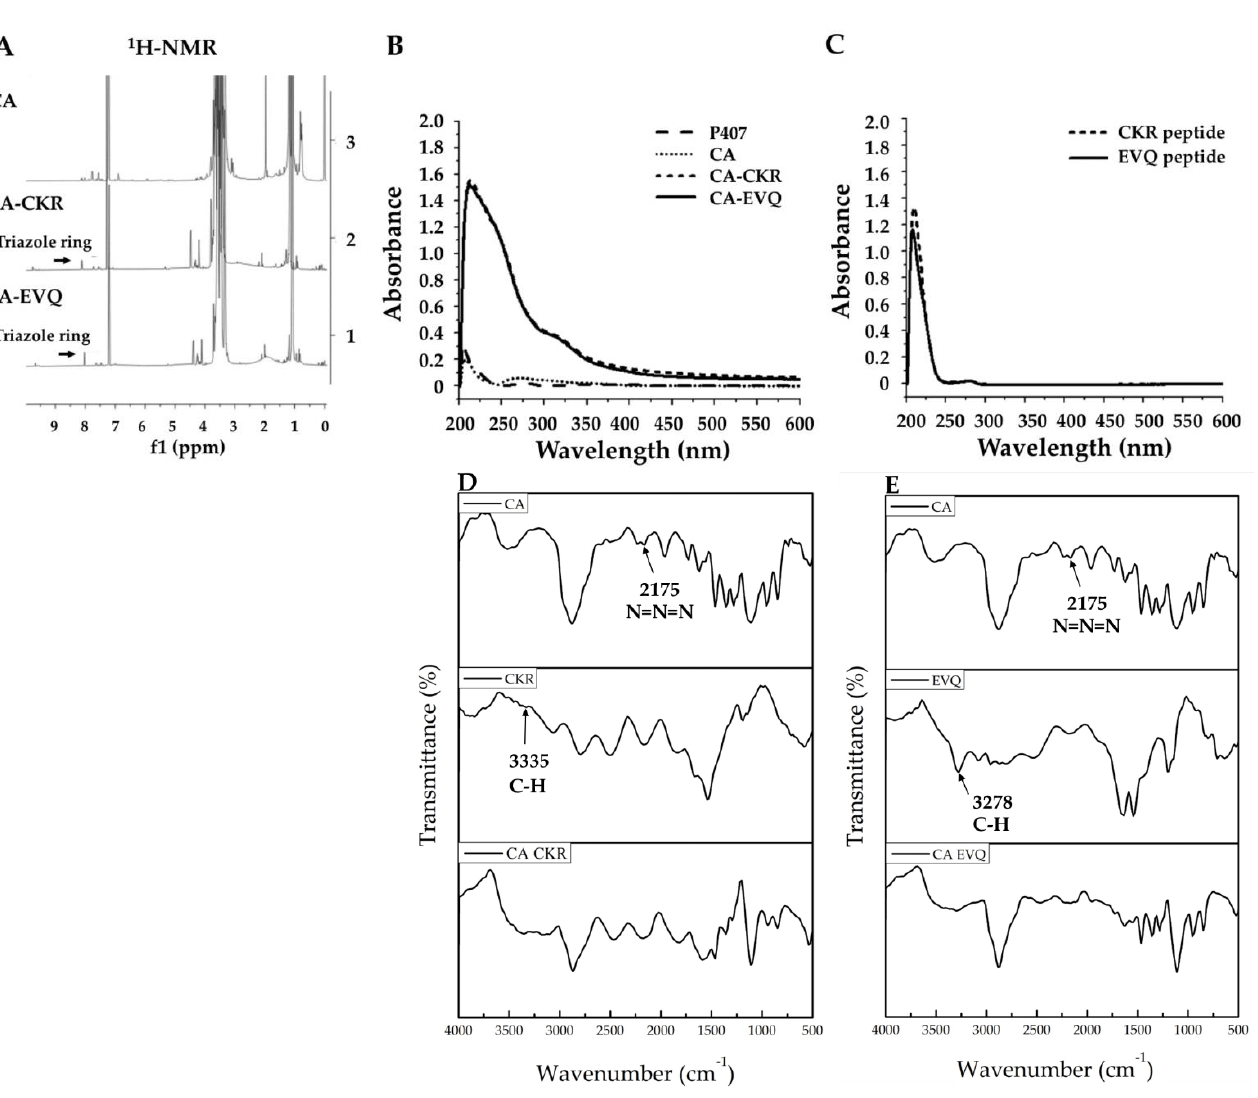
Figure 8. Characterization of cargo azide conjugated FLT3 peptides, CKR (CA-CKR) and EVQ (CA-EVQ). ( A ) 1 H-NMR spectrum of CA, CA-CKR, and CA-EVQ, ( B ) UV-Vis spectra of P407, CA, CA-CKR, and CA-EVQ, and ( C ) UV-Vis spectra of CKR and EVQ peptides. ( D ) FTIR spectra of CA, CKR peptides, CA-CKR, and ( E ) FTIR spectra of CA, EVQ peptides, and